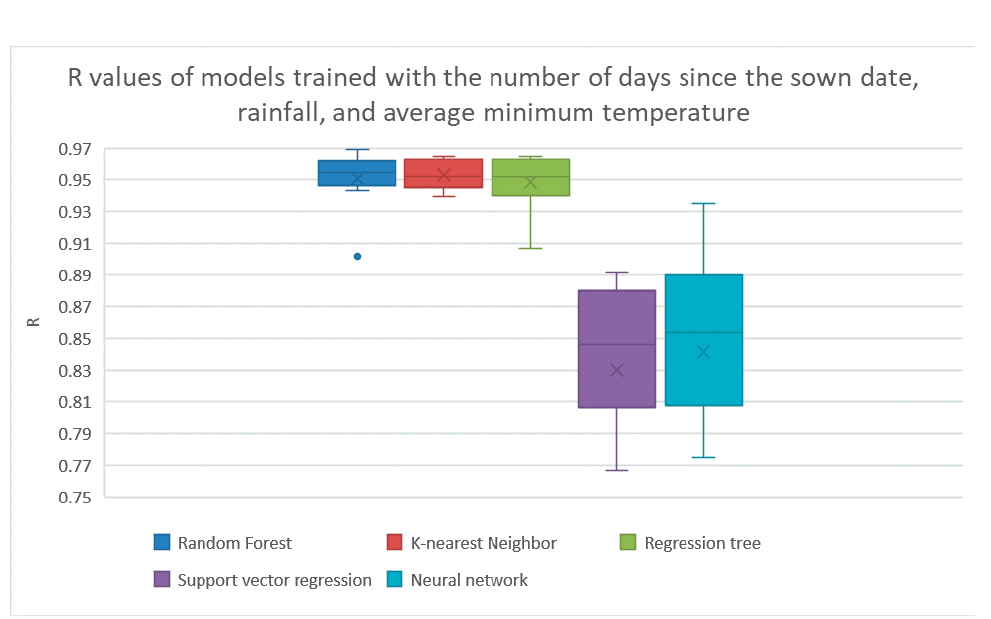
Figure 6. Results from ReliefF feature selection. The results from linear regression and Bayesian ridge regression were much